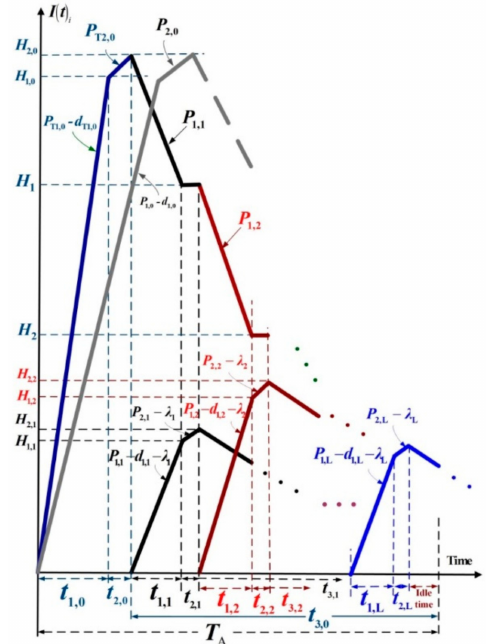
Figure 1. The stock level of the proposed multi-item two-stage postponement model with commonality, adjustable-rate, postponement, and rework as compared to the same system without the implementation of the expedited rate (in grey).